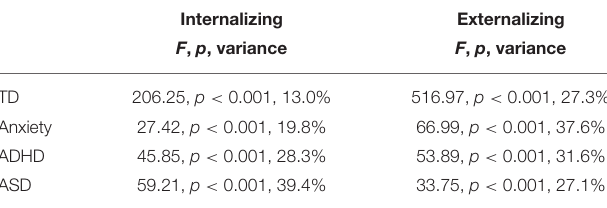
TABLE 3 | Regression results by subgroup: emotion regulation predicting internalizing and externalizing symptoms.